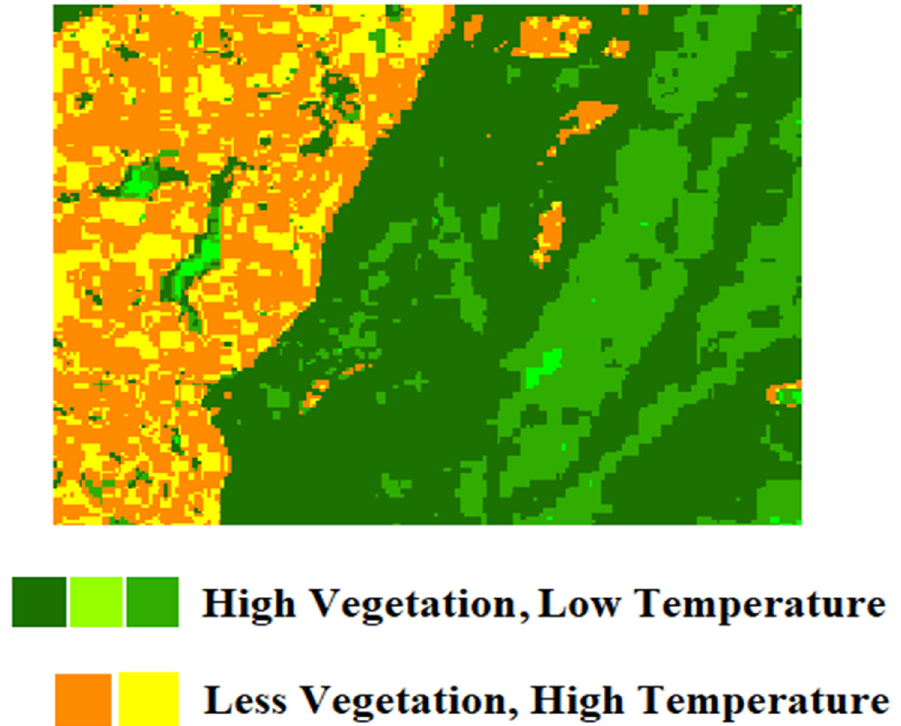
Figure 20. Training LU/LC–LST feature map for Bi-LSTM prediction model—Javadi Hills,